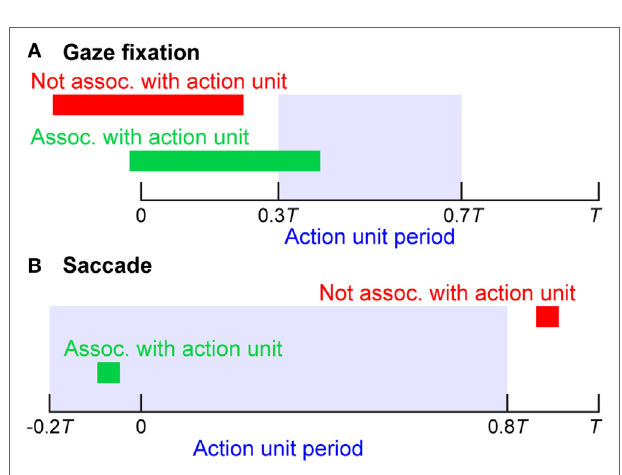
FigUre 3 | (a) A given gaze fixation period was associated with a specific action unit if the gaze fixation period overlapped with the action unit period ranging from 0.3 to 0.7 T (blue shaded region), where T was the duration of the specific action unit. (B) A given saccade was associated with a specific action unit if the saccade occurred during the action unit period ranging from − 0.2 to 0.8 T .